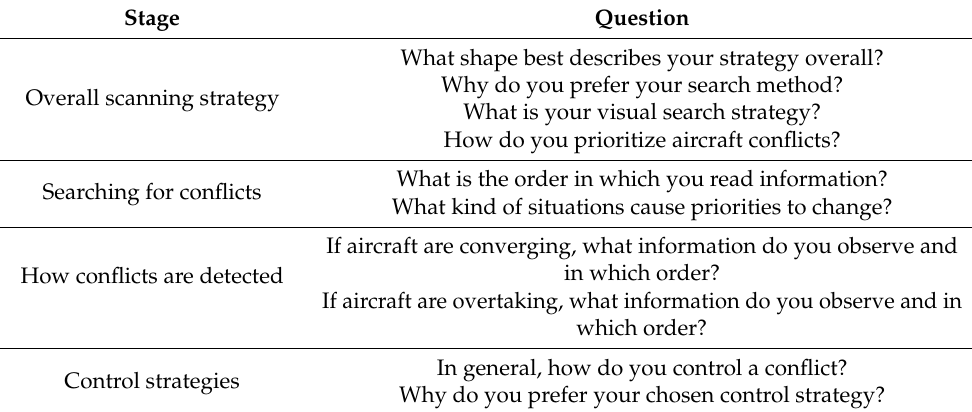
Table 1. Interview questionnaire.